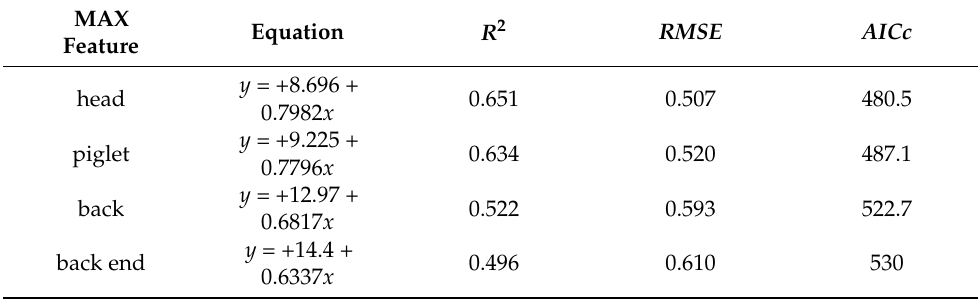
Figure 6. Progress of the fine-tuning process of the YOLOv3-SPP model on the training set (n = 316) for 300 epochs. The evaluation of the metrics precision, recall, and mAP is performed on the validation set (32 images). Table 3. Results of simple linear regression of the max values of body features on rectal temperature. R 2 is the coefficient of determination, RMSE is the root mean square error, and AICc is a variation of the Akaike information criterion for small sample sizes. y represents the rectal temperature and x the max value of the